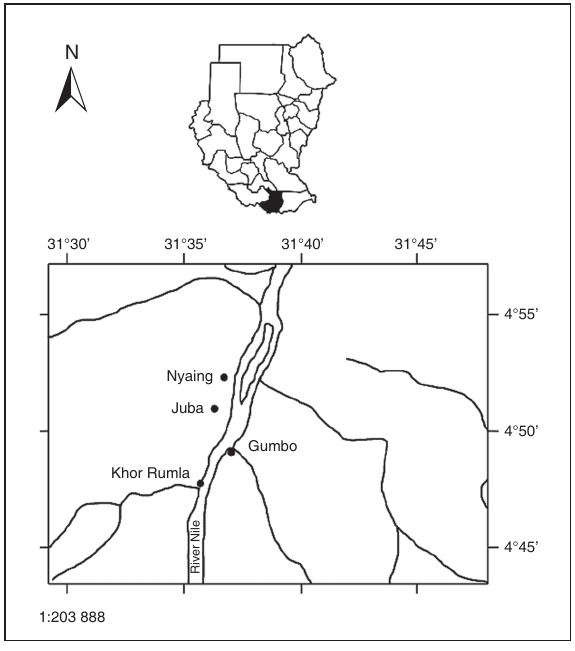
Locations where samples were collected from Central Equatoria State, Southern Sudan. Top: map of the Su- dan depicting its state boundaries. Black area: Central Equatoria State. Bottom: Juba area in Central Equatoria State depicting the locations where the samples were collected